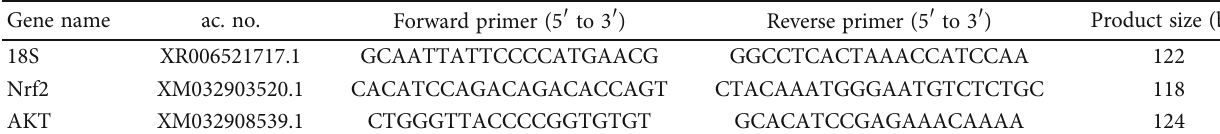
Table 2: The primers ’ sequences used to perform real-time PCR.